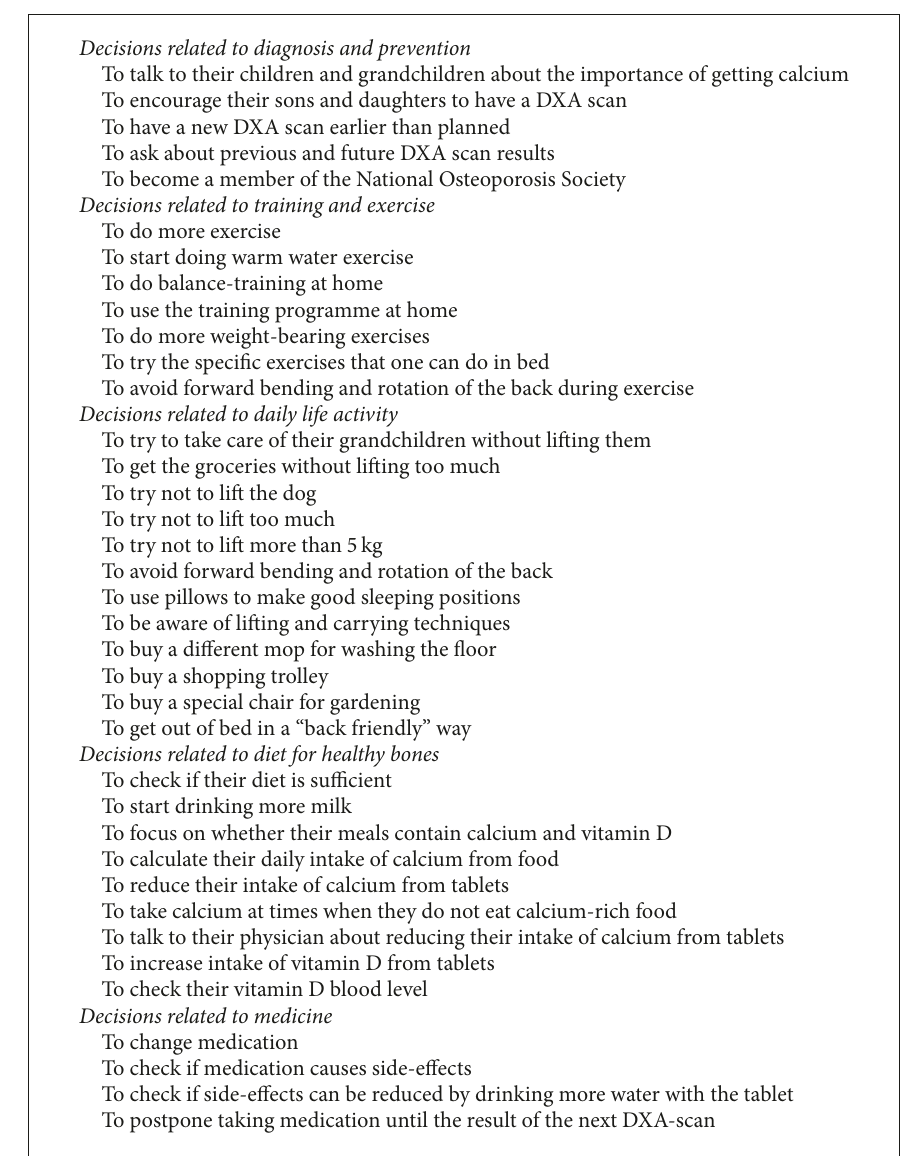
Box 3: Patients’ articulated decisions related to five overall